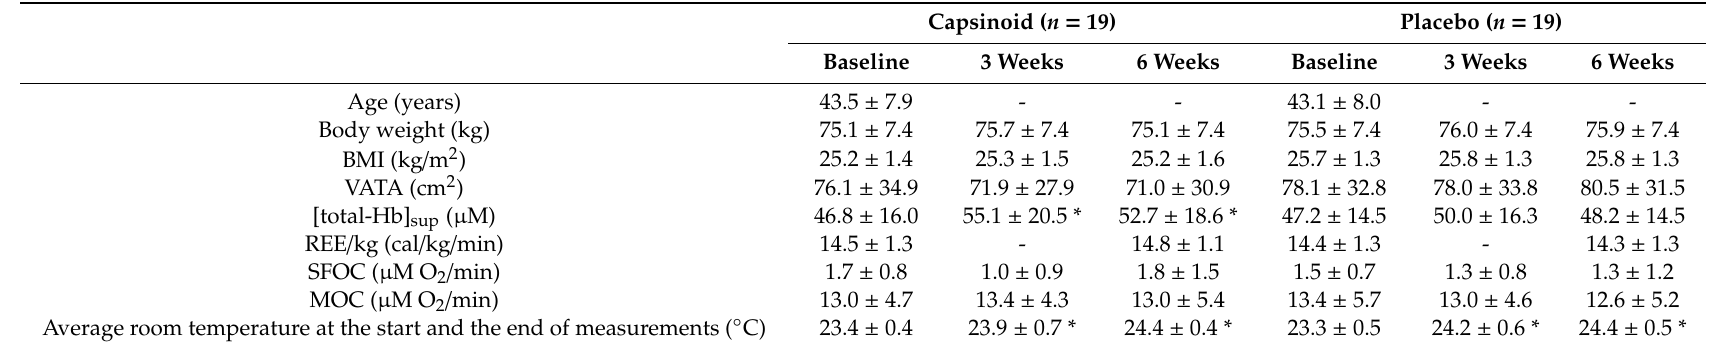
Table 1. Subject profiles and the average room temperature at each measurement